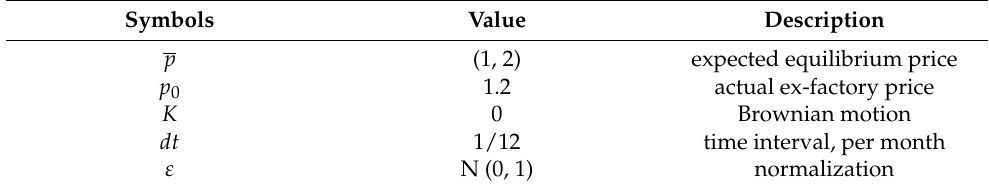
Table 2. Parameter list of natural gas price forecast